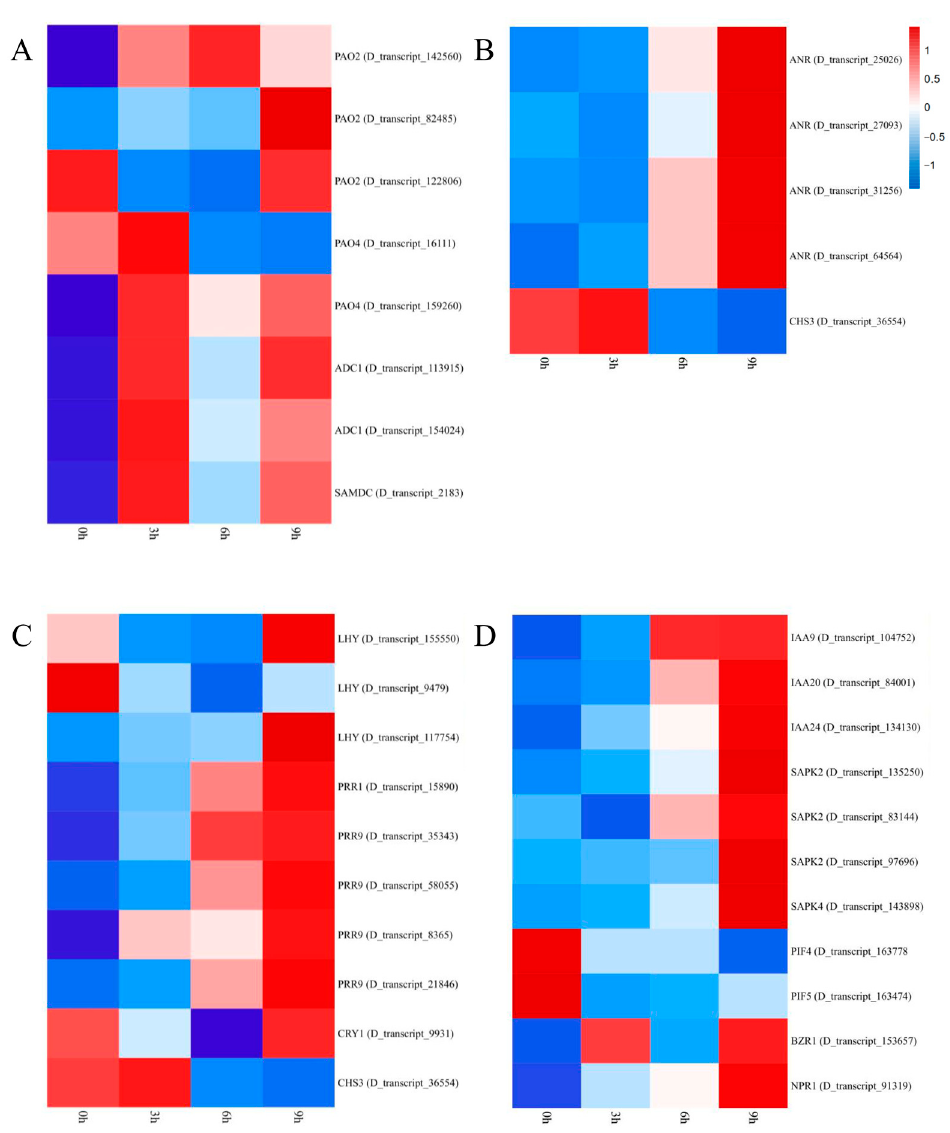
Figure 4 . Heatmaps showing the expression of genes related to the arginine and proline metabolism pathways ( A ), flavonoid biosynthesis pathway ( B ), plant circadian rhythm pathway ( C ) and plant hormone signal transduction pathway ( D ).